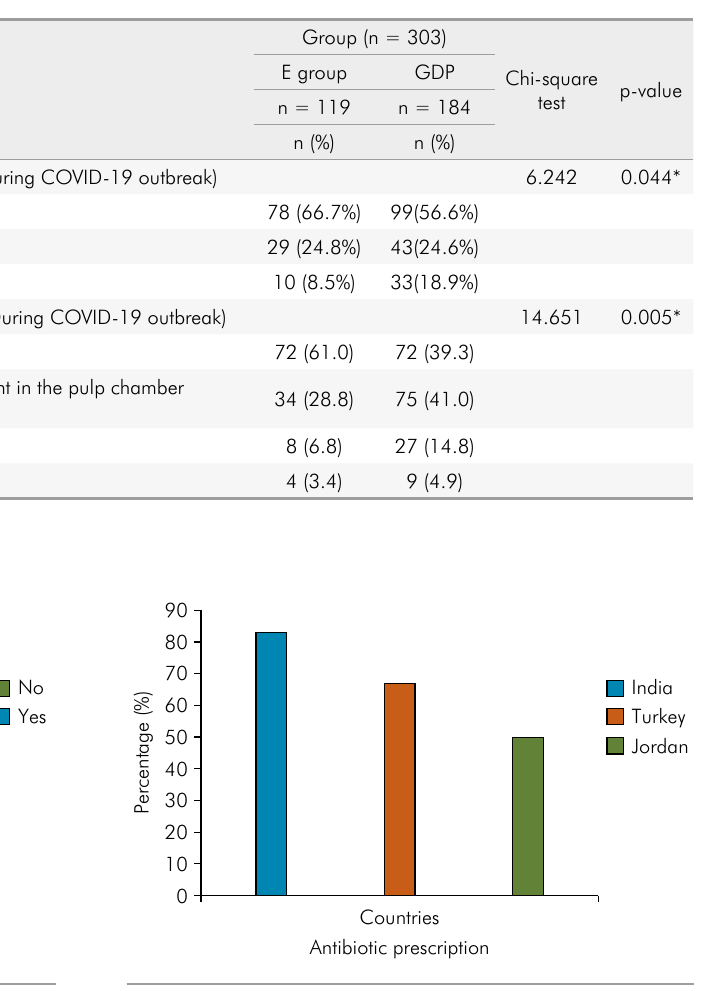
Figure 3. Percentages of antibiotic prescription for India, Turkey, and Jordan in case of symptomatic irreversible